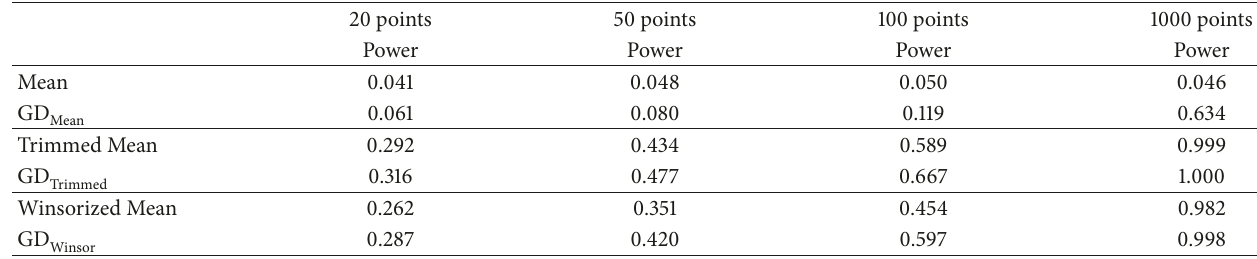
Table 29: Exponential distributions with 30% noise level.